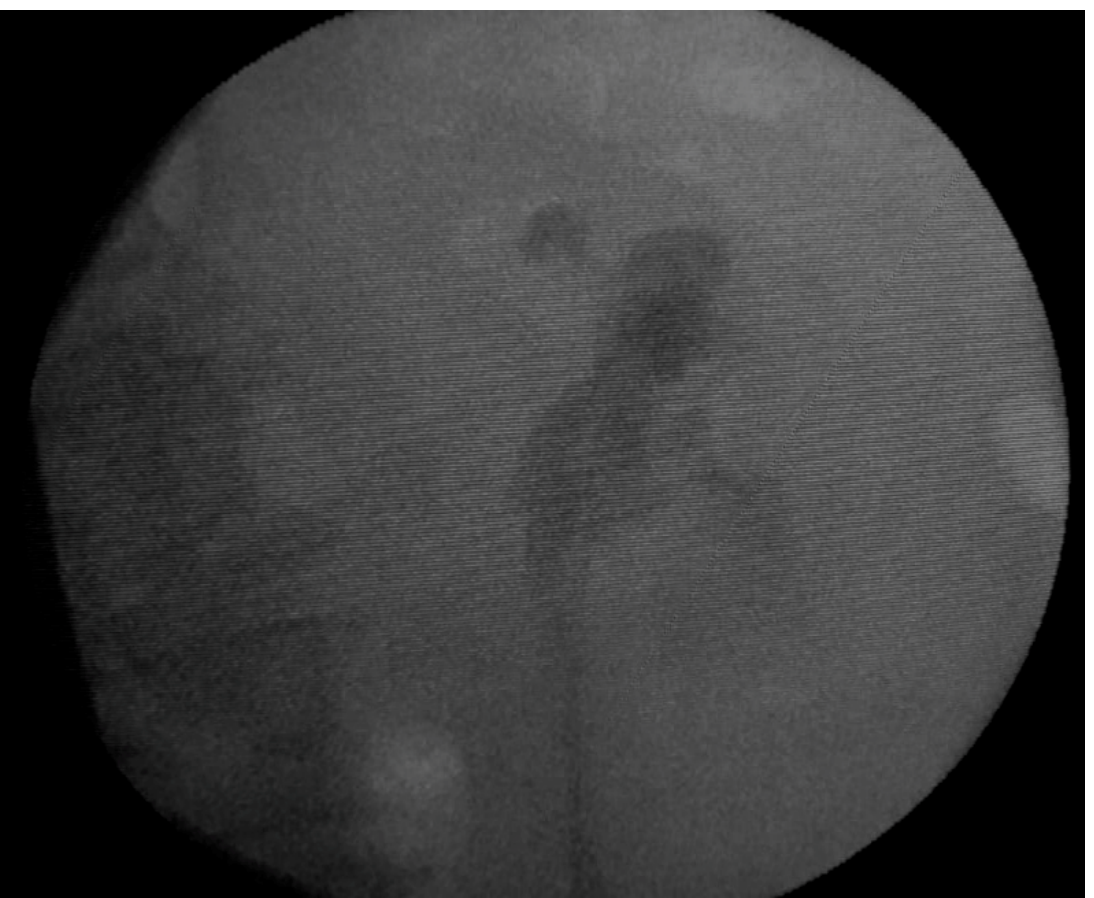
Figure 3. Fluoroscopic image after the placement of the left ureteric